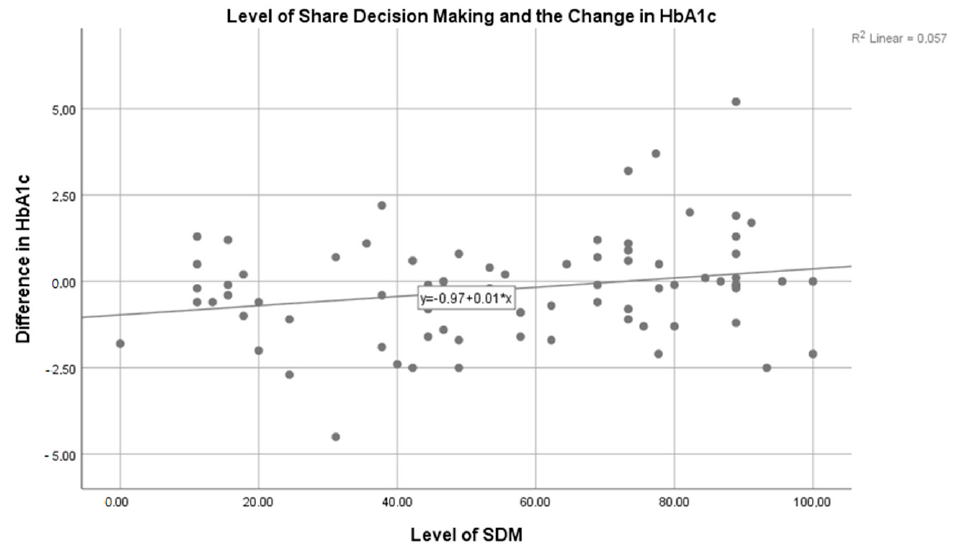
Figure 1. Relation of the level of SDM and the change in HbA1c. Scatter-plot assessing the regression model explaining the change in HbA1c with the Level of SDM by 5.7%. This model was statistically significant ( p = 0.038).